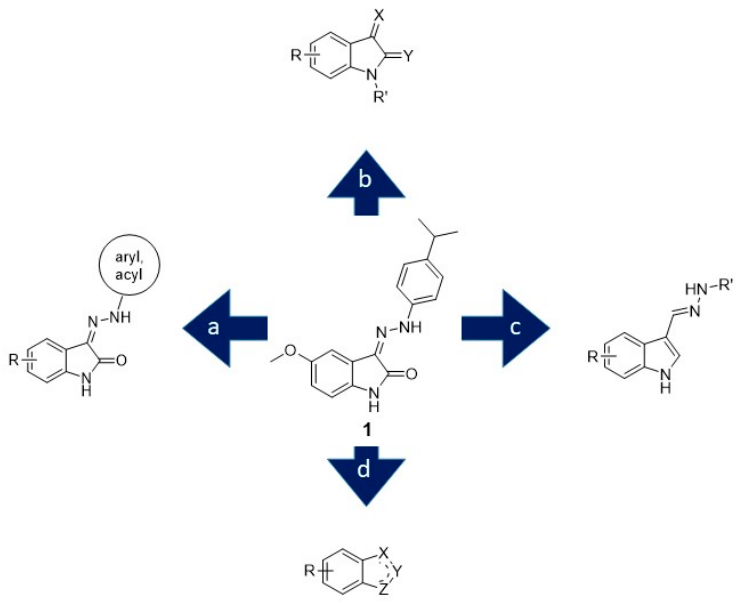
Figure 1. Ligand-based design of new inhibitors of amyloid aggregation.